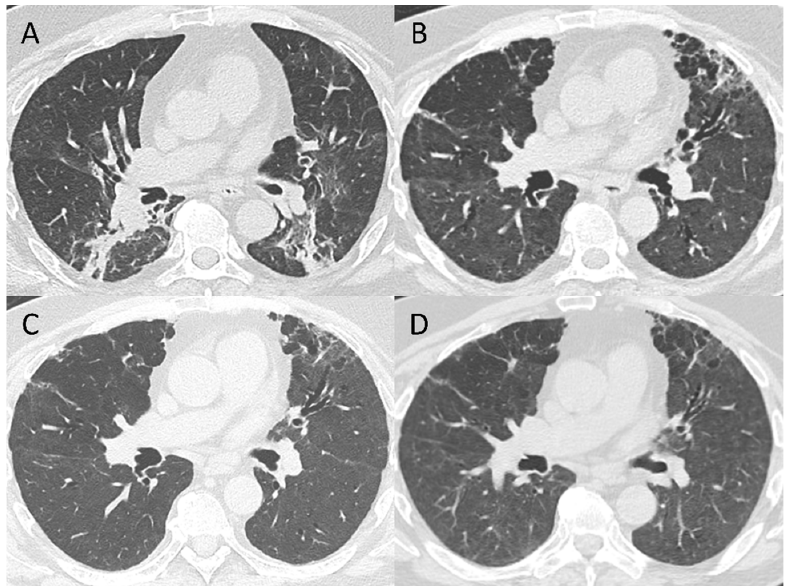
Figure 4. Representative CT images of post-ventilatory residual fibrotic abnormalities in a patient who received invasive mechanical ventilation. From baseline ( A ) to 3-month follow-up CT scan ( B ) a progressive resolution of GGO and consolidations at lower lobes can be observed, together with the appearance of bronchiectasis, GGO, and cystic spaces in the subpleural interface of the anterior part of the upper left lobe in keeping with post-ventilatory damage. These abnormalities are persistent at 6-month ( C ) and 12-month follow-up CT scans, even if a decrease in residual disease extension can be observed ( D